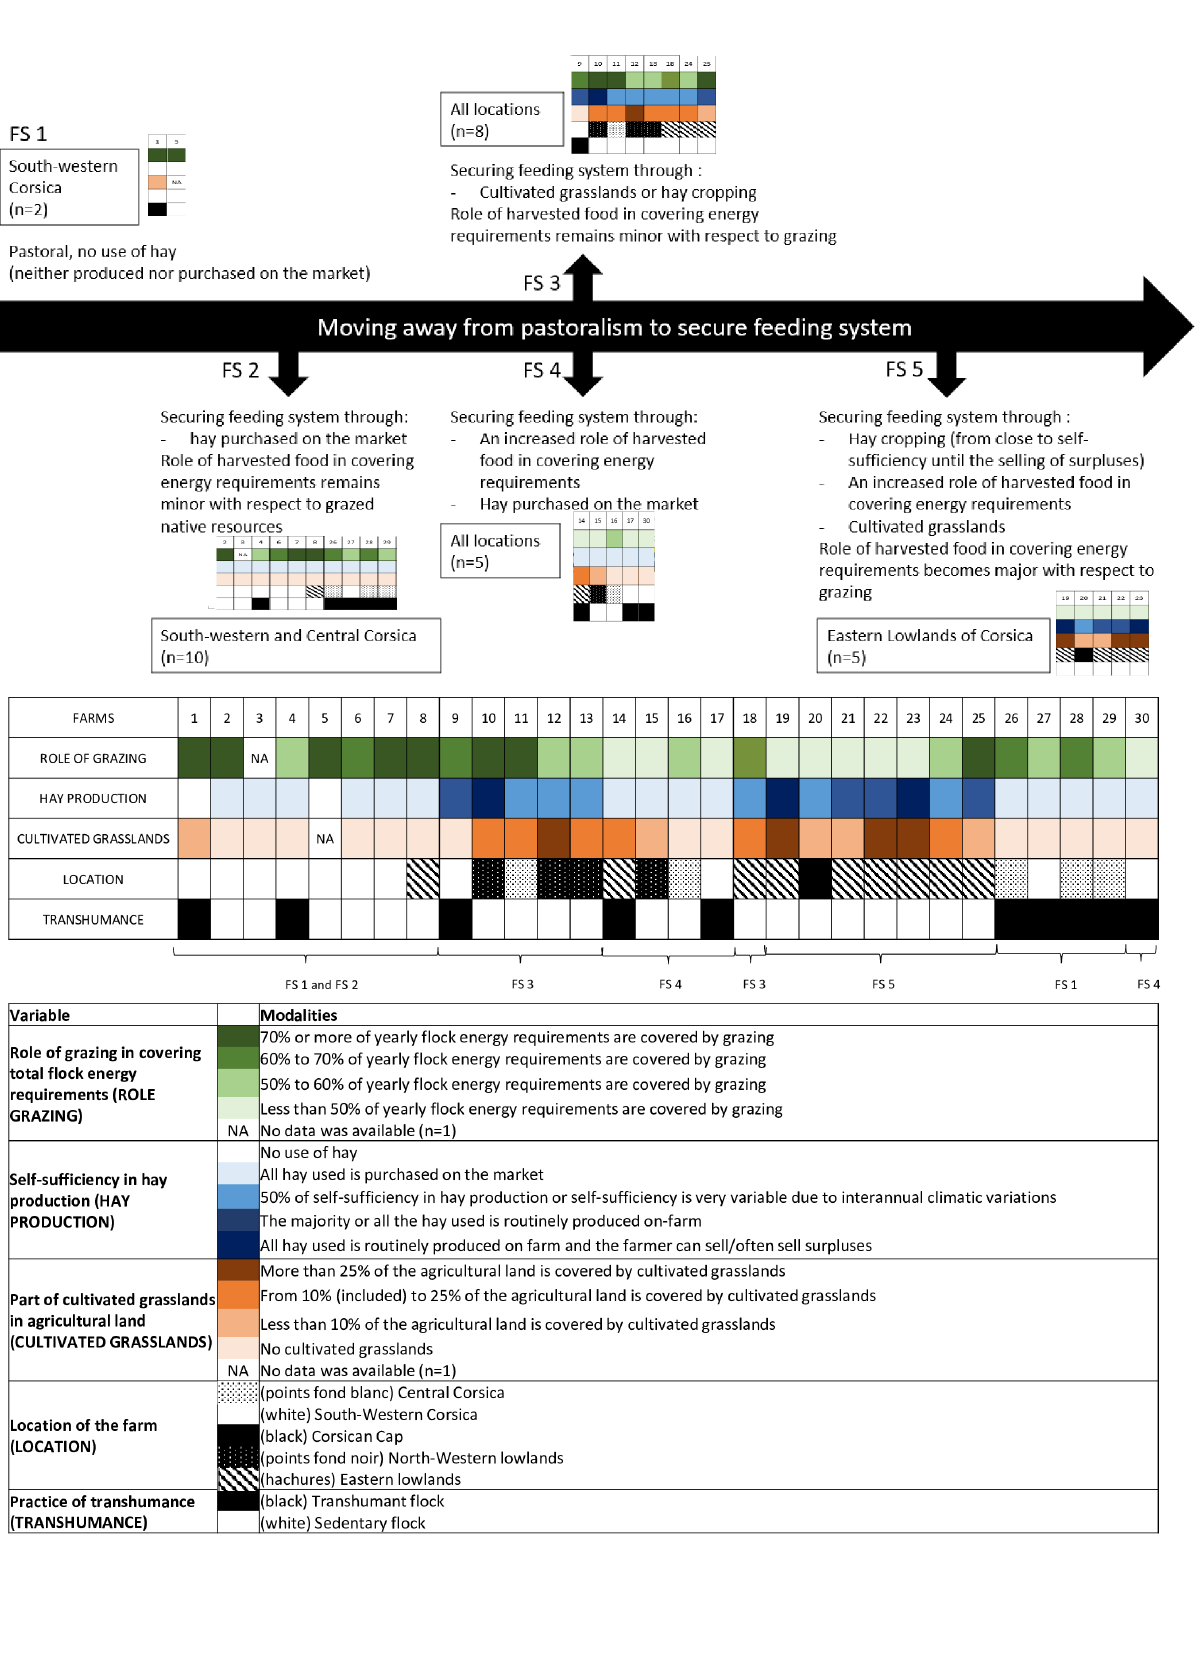
Figure 2. Diversity of the feeding systems among the local purebred flocks in Corsica (results on 30